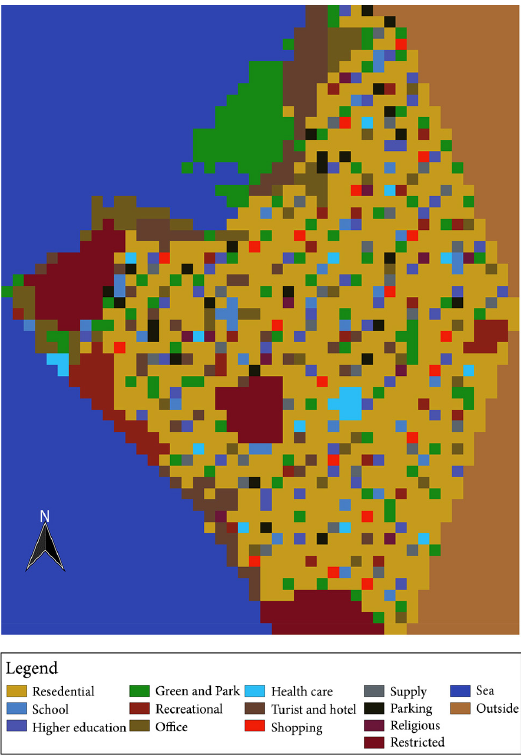
Figure 12. A land-use map from Zanzibar city (case study area), when a trade-off between compatibility and travel distance is applied (selecting point 2 from Figure 9)